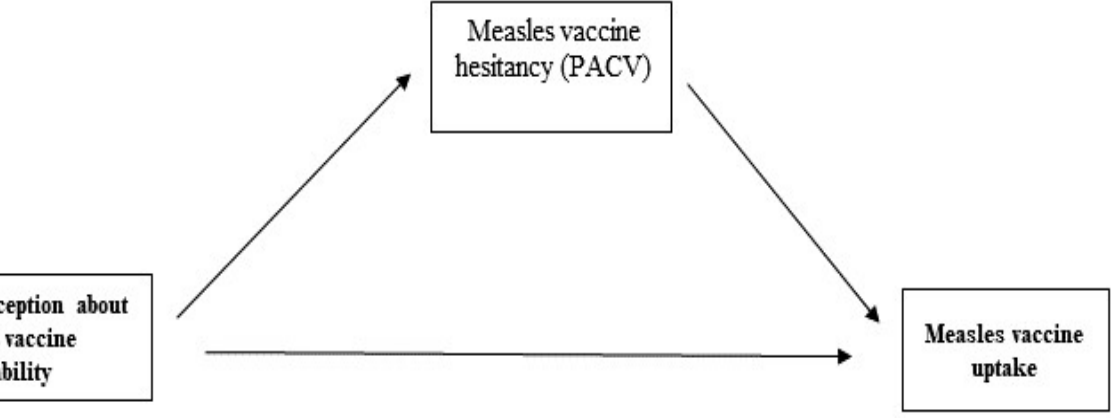
Figure 1. Mediation with the path of Measles Vaccine Hesitancy (PACV scores) as the mediator in the relationship between parental perception about measles vaccine availability and measles vaccine uptake.